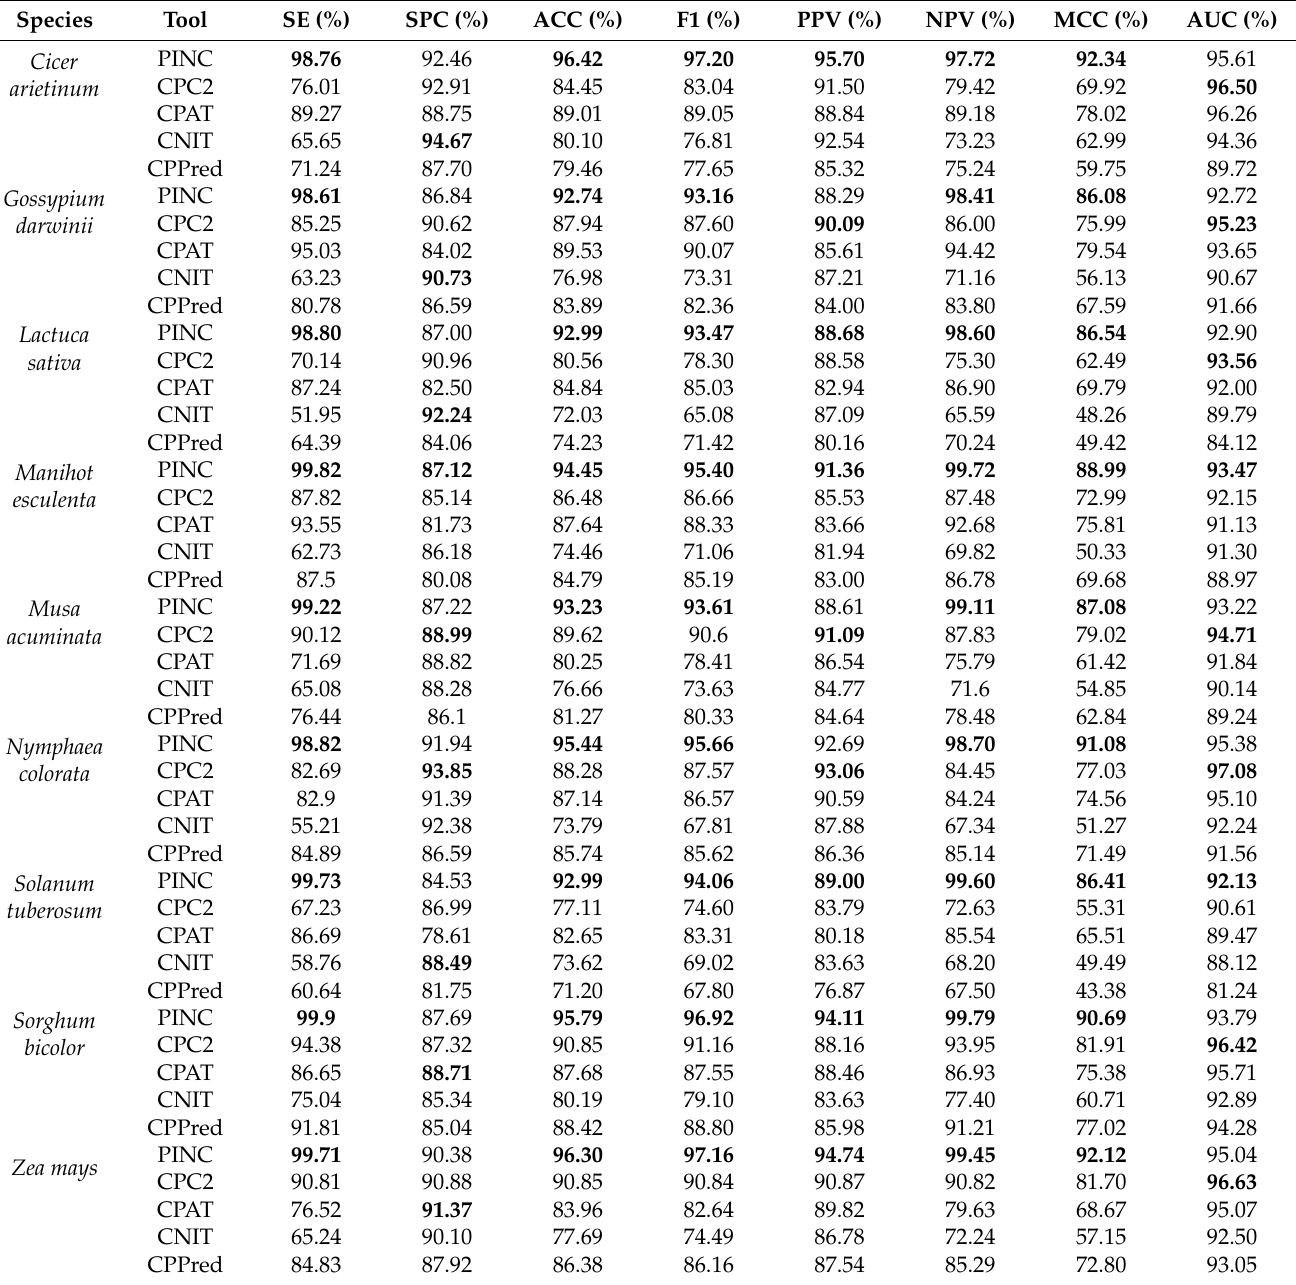
Table 3. Nine plants’ performance indicators were compared using five